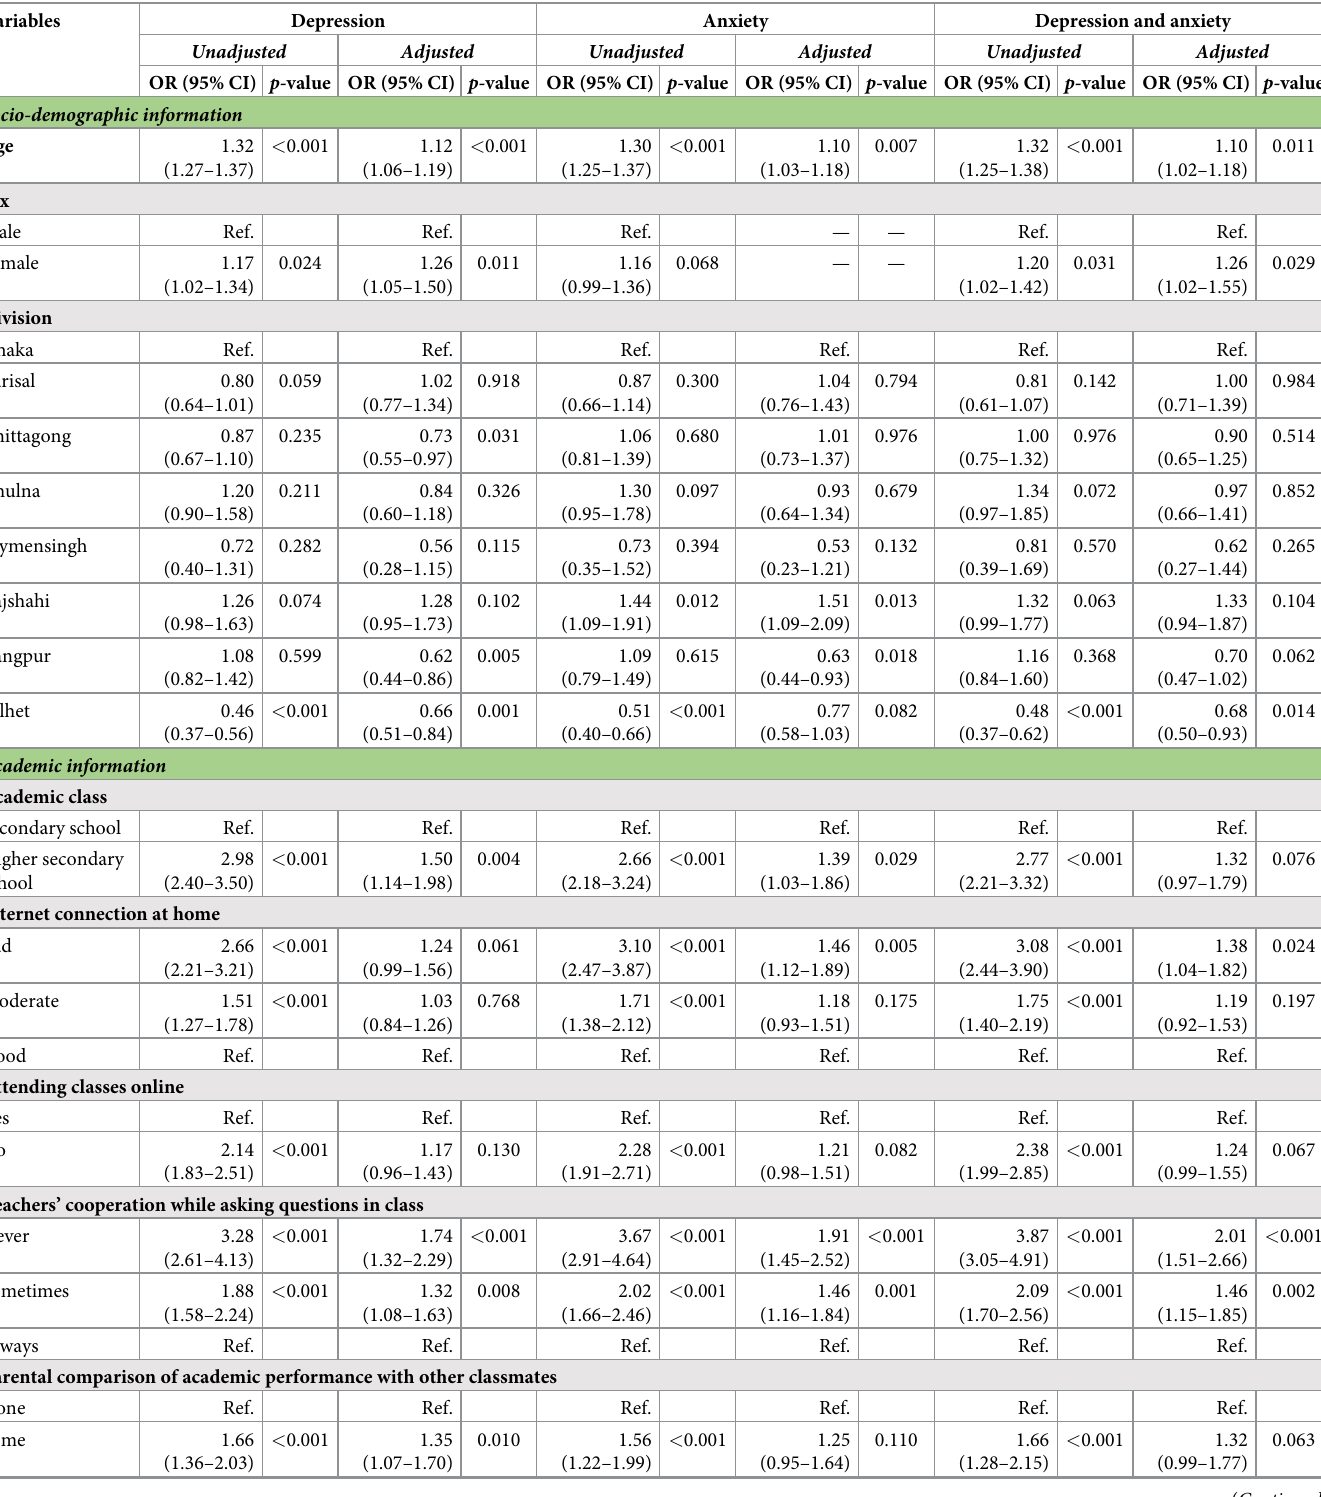
Table 2. Regression analysis by mental health